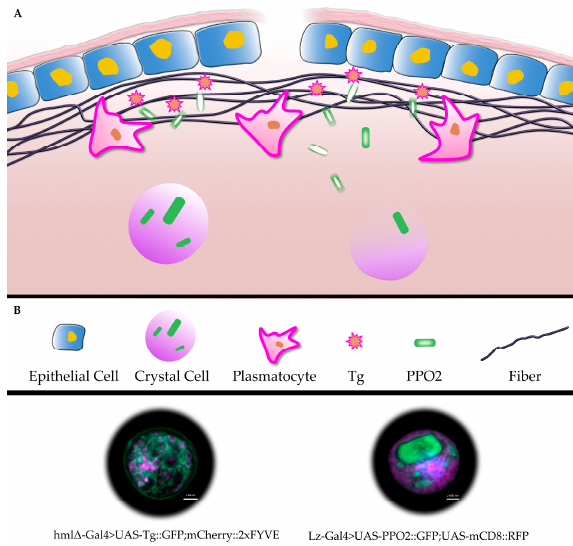
Figure 1. Schematic representation of clot formation in Drosophila larvae ( A ): structural components of the fibers (Fondue) are cross-linked, initially by transglutaminase and subsequently by phenoloxidase. ( B ) shows a key to the schematic as well as a plasmatocyte (lower part, inset to the left, with GFP-tagged transglutaminase) and a crystal cell (inset to the right, with GFP-tagged PPO2 in crystalline structures, nuclear staining with 4’,6-diamidino-2-phenylindole (DAPI), note that PPO2-containing crystals dissolve after release from crystal cells, indicated by a lighter shading [41] see text for further details).